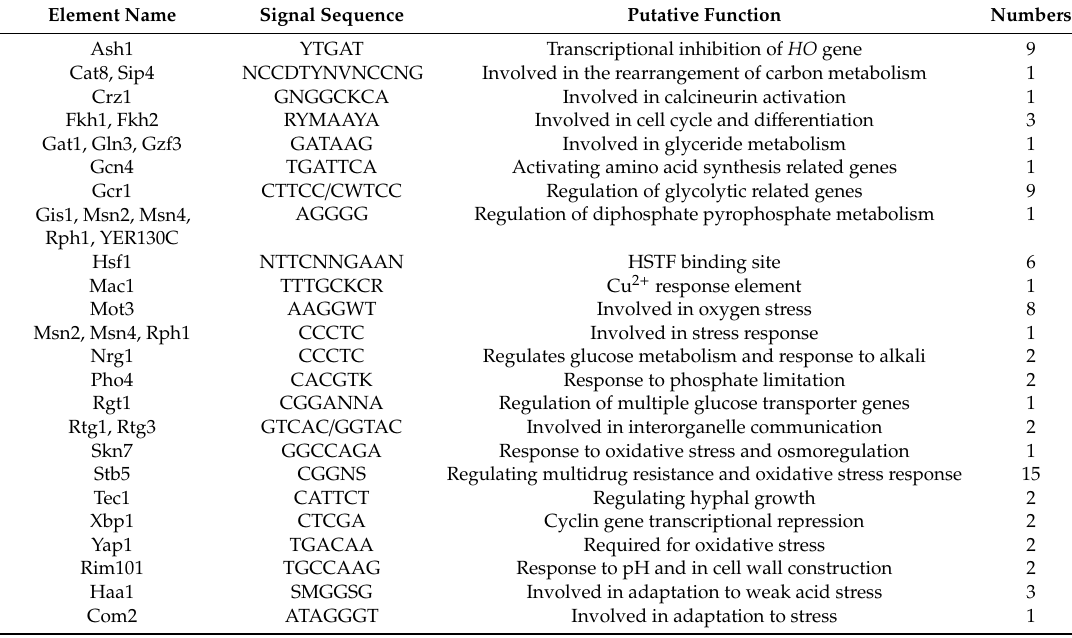
Table 2. The transcription factor binding sites predicted by